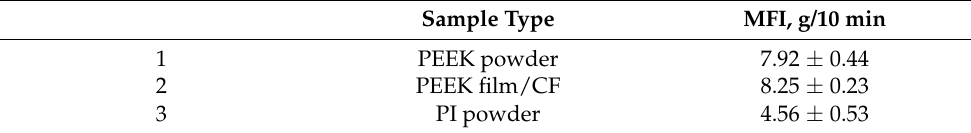
Table 1. MFI of polymers.